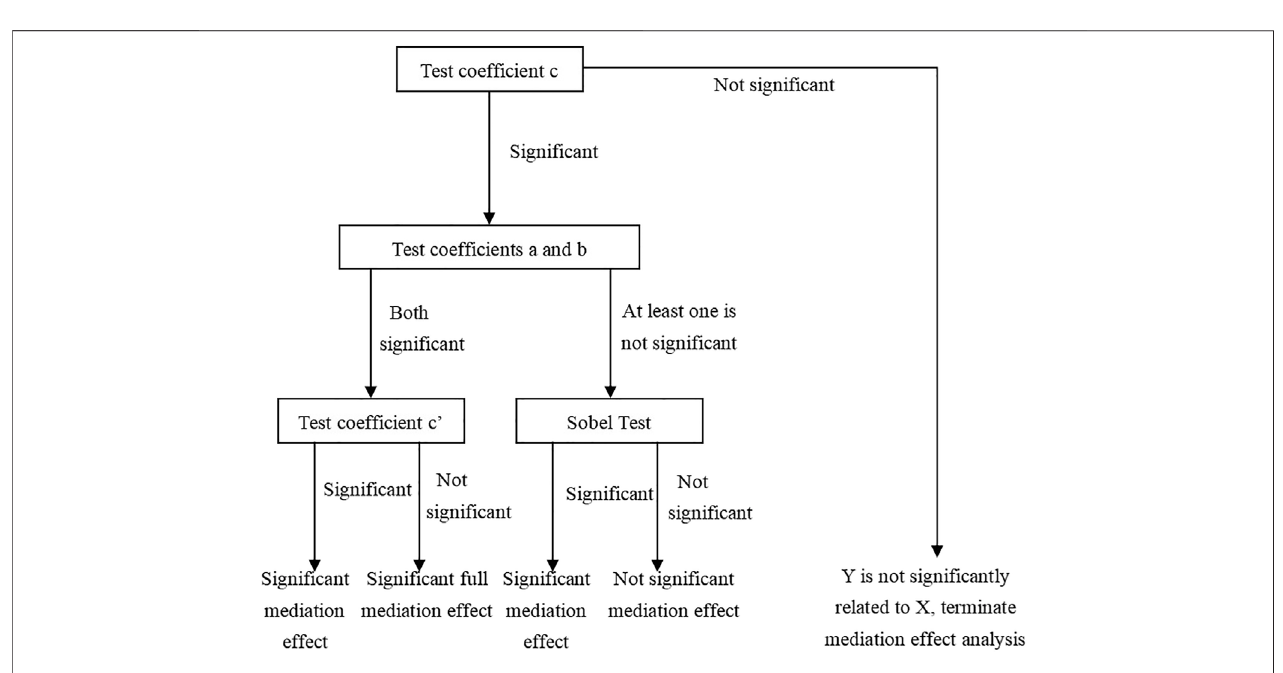
FIGURE 4 | Mediating effect test